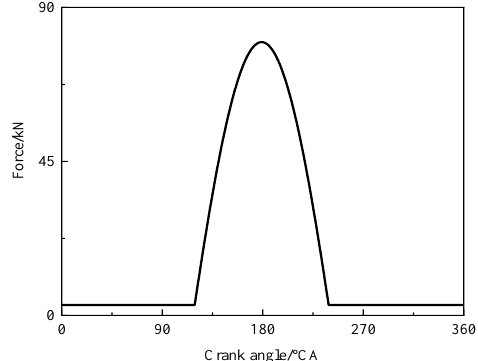
Figure 4. Full load spring force.